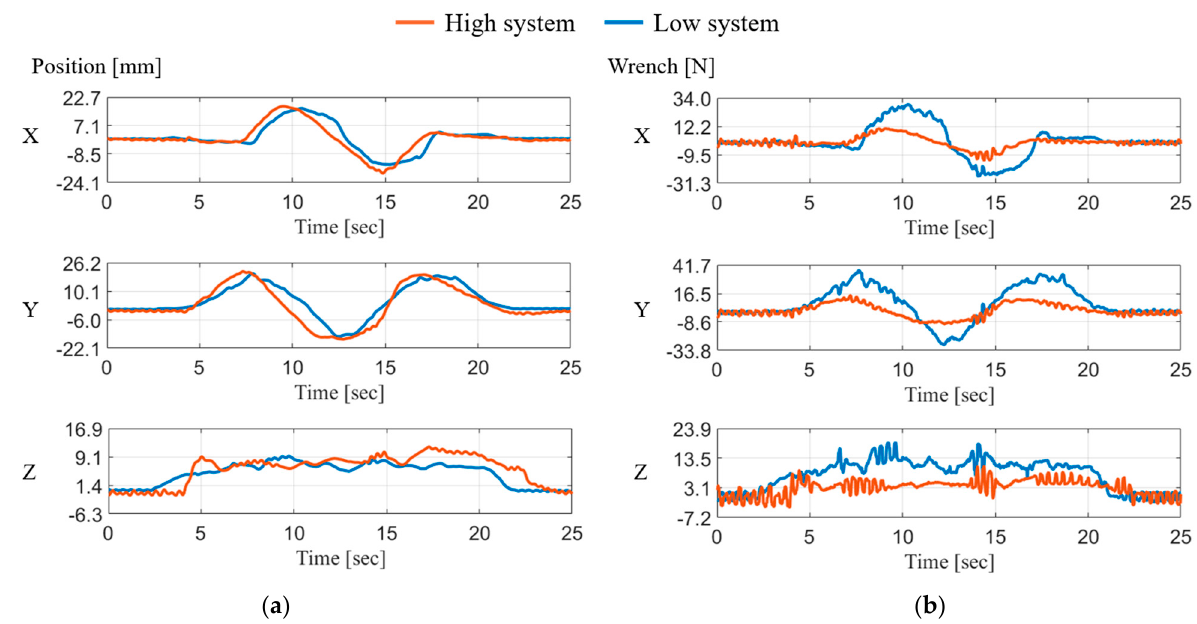
Figure 9. Comparison of the ( a ) position value and ( b ) applied wrench force according to the different virtual systems.